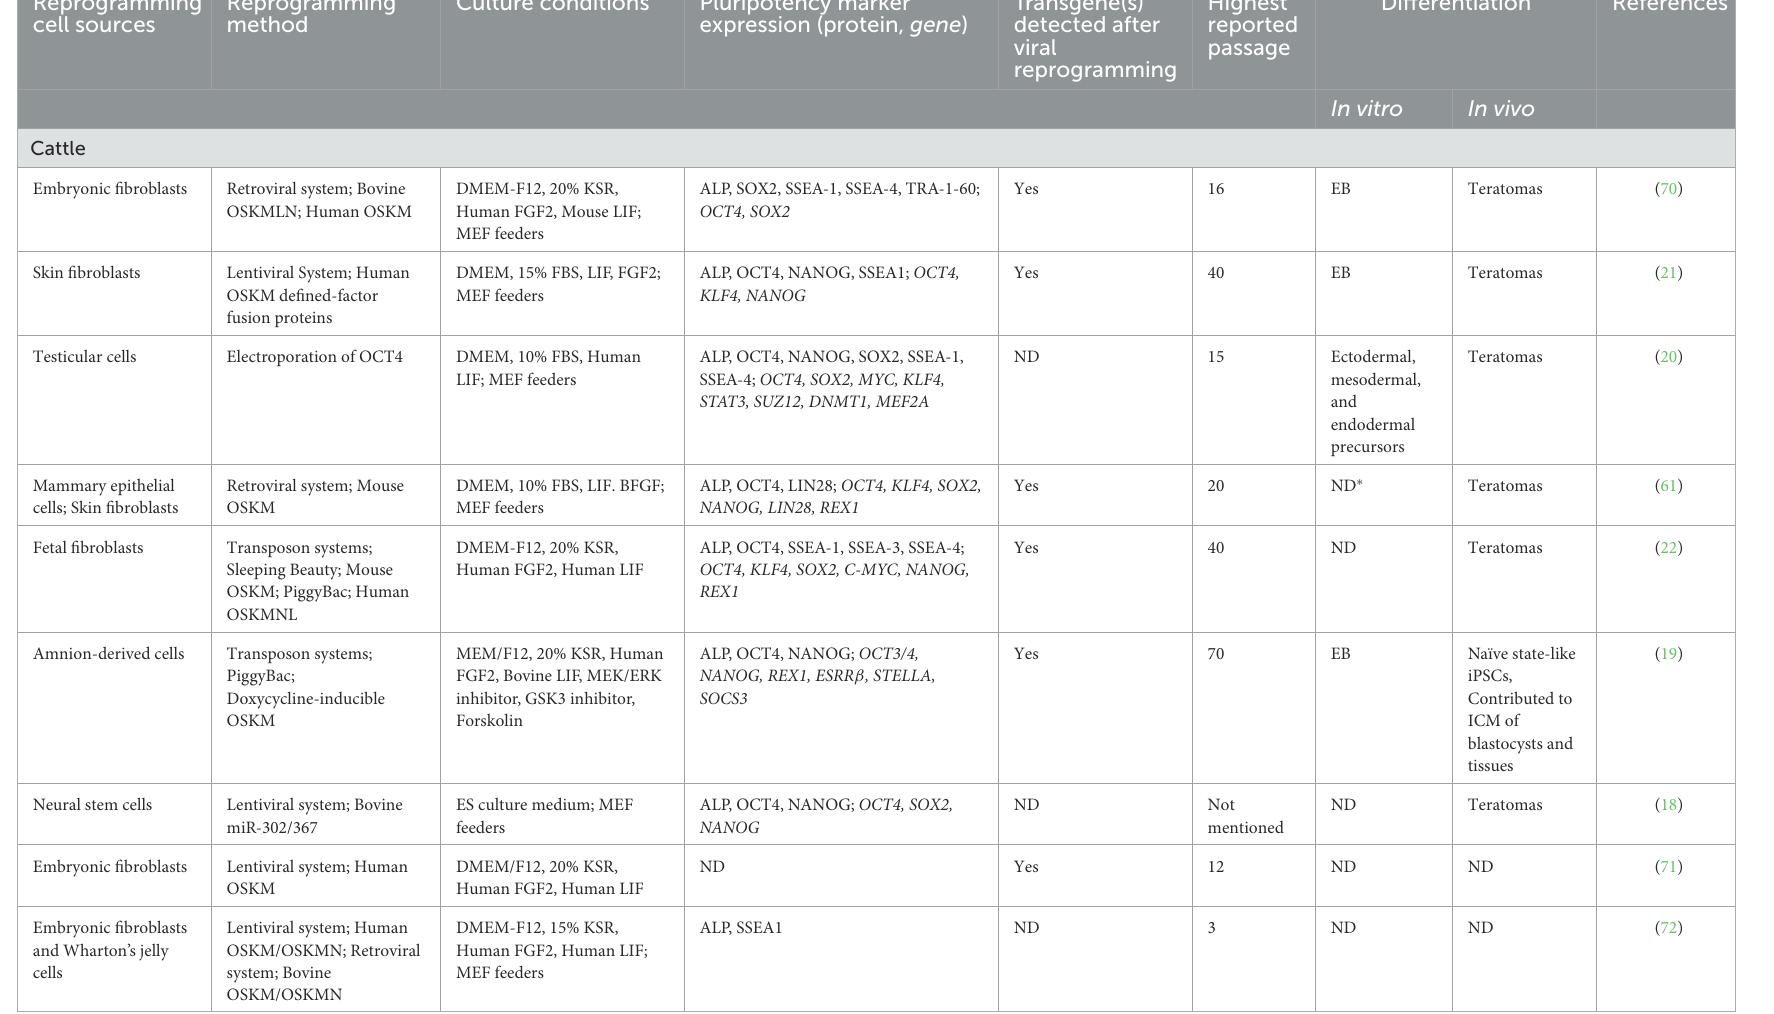
TABLE 1 Summary of induced pluripotent stem cells (iPSCs) generated from cattle, sheep, goat, and